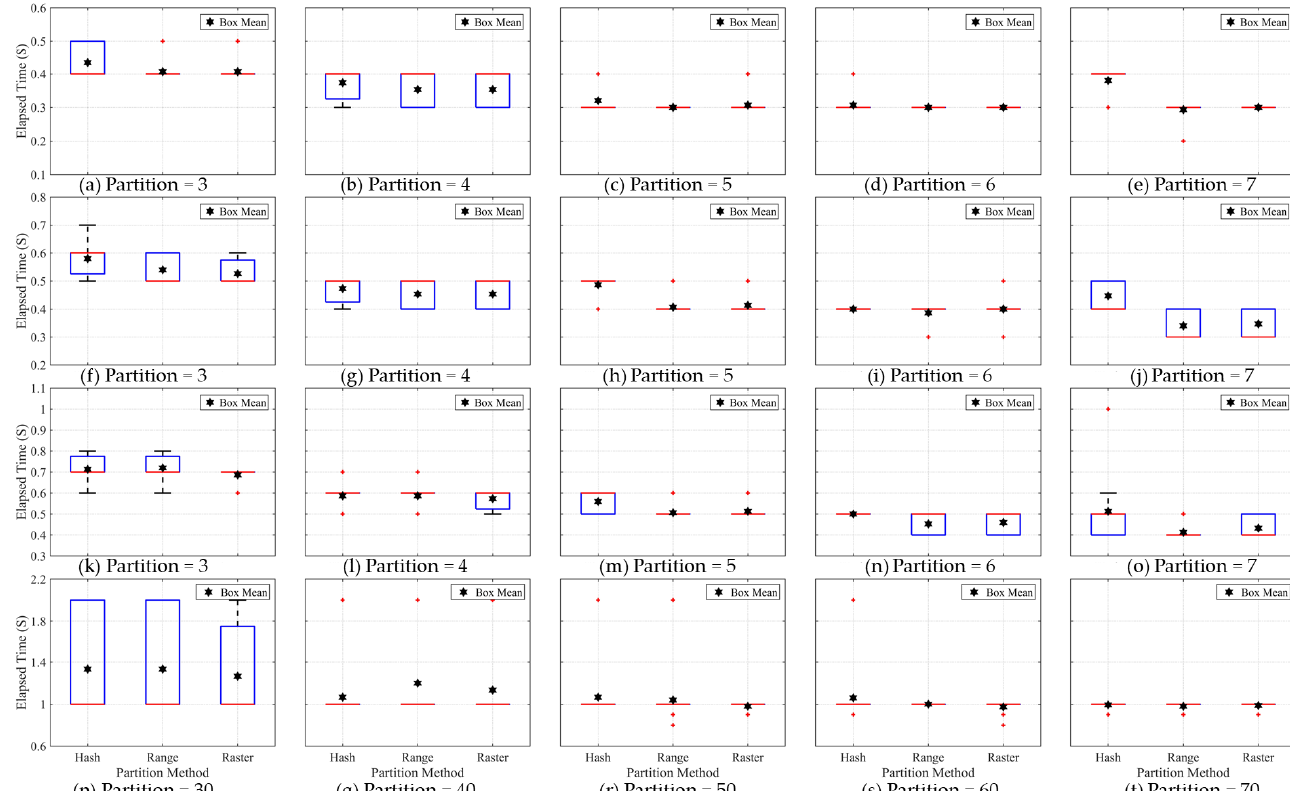
Figure 10. The elapsed time for the image clipping